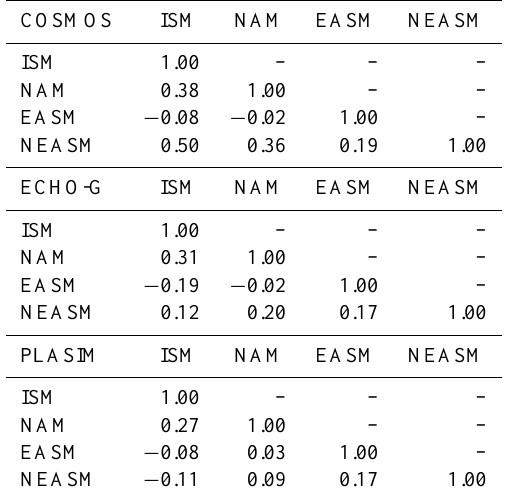
Table 4. Pearson correlation coefficients for the rainfall time se- ries in the different monsoon sub-regions, i.e. the Indian monsoon region (ISM), North African monsoon region (NAM), East Asian monsoon region (EASM), and the northern part of the East Asian monsoon region (NEASM). The time series have been detrended by a 500-year moving average before calculating the correlation coef- ficients. Only the non-accelerated simulations have been used.